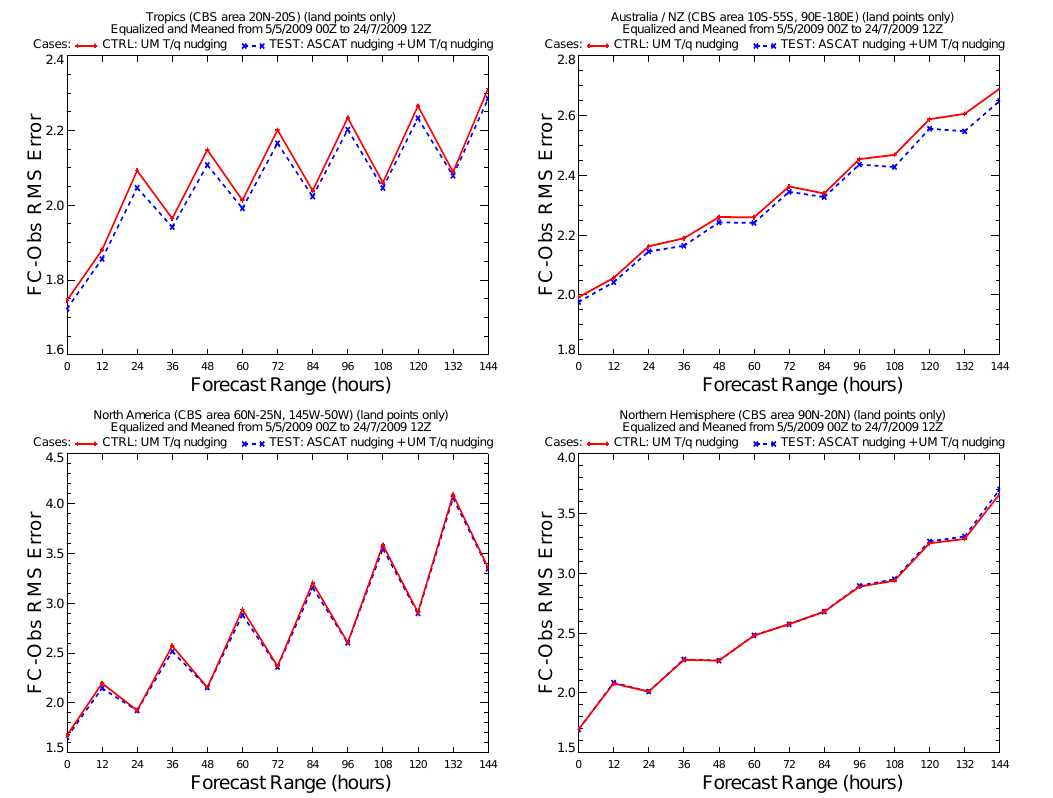
Fig. 8. Trial 1 verification of UM screen temperature forecasts against observations for land points only and the time period 5 May 2009 to 24 July 2009. The solid red lines (dashed blue lines) show RMS differences for the Control experiment (Test experiment that also assimilates ASCAT surface soil wetness measurements). Results are shown for the tropics (20 ◦ S to 20 ◦ N), Australia (55 ◦ S to 10 ◦ S, 90 ◦ E to 180 ◦ E), North America (25 ◦ N to 60 ◦ N, 145 ◦ W to 50 ◦ W) and Northern Hemisphere regions (20 ◦ N to 90 ◦ N). 39 observations. Therefore the total error in the USDA SCAN observations is about 0.07 m 3 m − 3